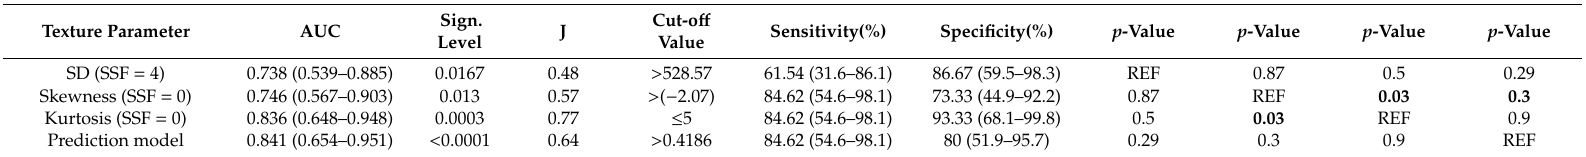
Table 6. Receiver operating analysis results for the di ff erentiation of malignant from benign lesions. Each p -value column represents the comparison between all parameters and the reference one